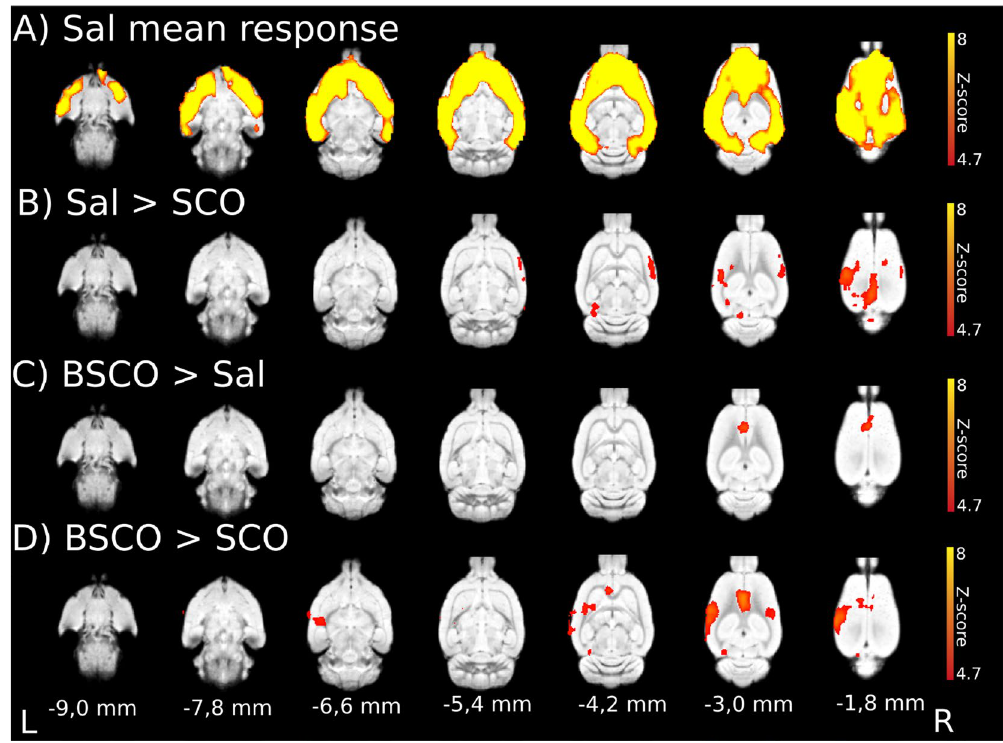
Figure 2. Whisker stimulation evoked BOLD response and evoked BOLD response differences between pretreatment groups with GE EPI sequence in isoflurane anesthesia (n = 54; 18 per pretreatment group). ( A ) Mean activation response evoked by whisker sensory stimulation in the saline group. ( B ) Decreased BOLD response in the scopolamine (SCO) treated group compared to saline (Sal > SCO). ( C ) Increased BOLD response in the butylscopolamine (BSCO) group compared to saline (BSCO > Sal). ( D ) Differences between the SCO and BSCO treated groups (BSCO > SCO). The Z-scores represent probabilistic TFCE (pTFCE) statistics (p < 0.05 correcting for multiple comparisons via GRF theory based FWER, red-to-yellow z = 4.7 to z = 8) from the same data. The corresponding colorbars are depicted on the right. The z coordinates (distance from Bregma) of the selected slices (− 9.0 mm; − 1.8 mm) are given at the bottom of the figure (L and R stand for